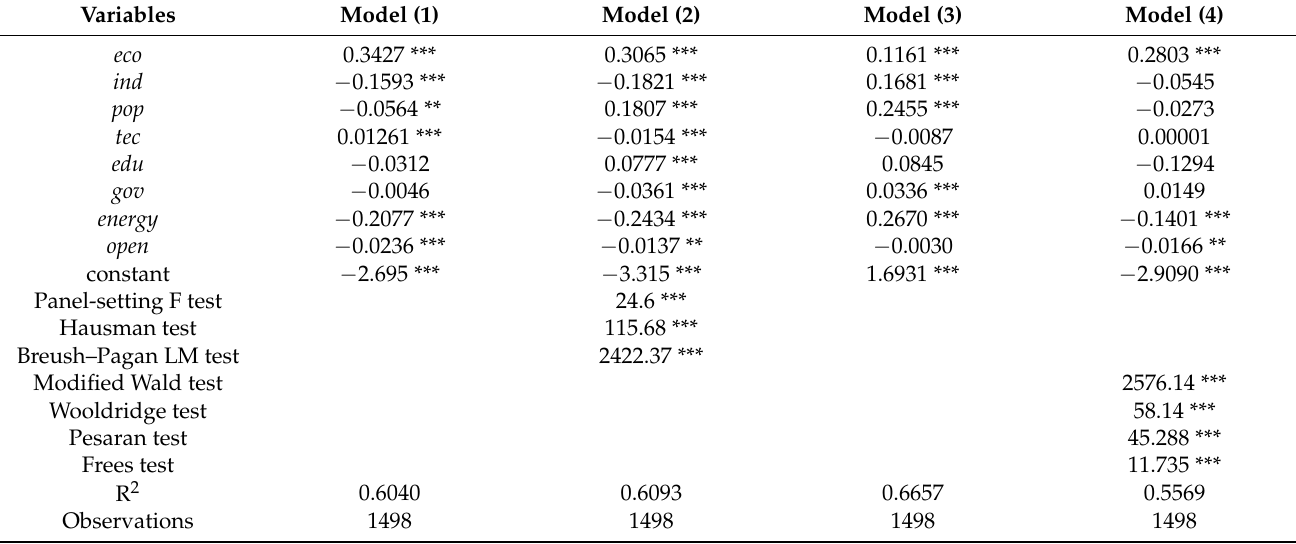
Table 5. Model estimation